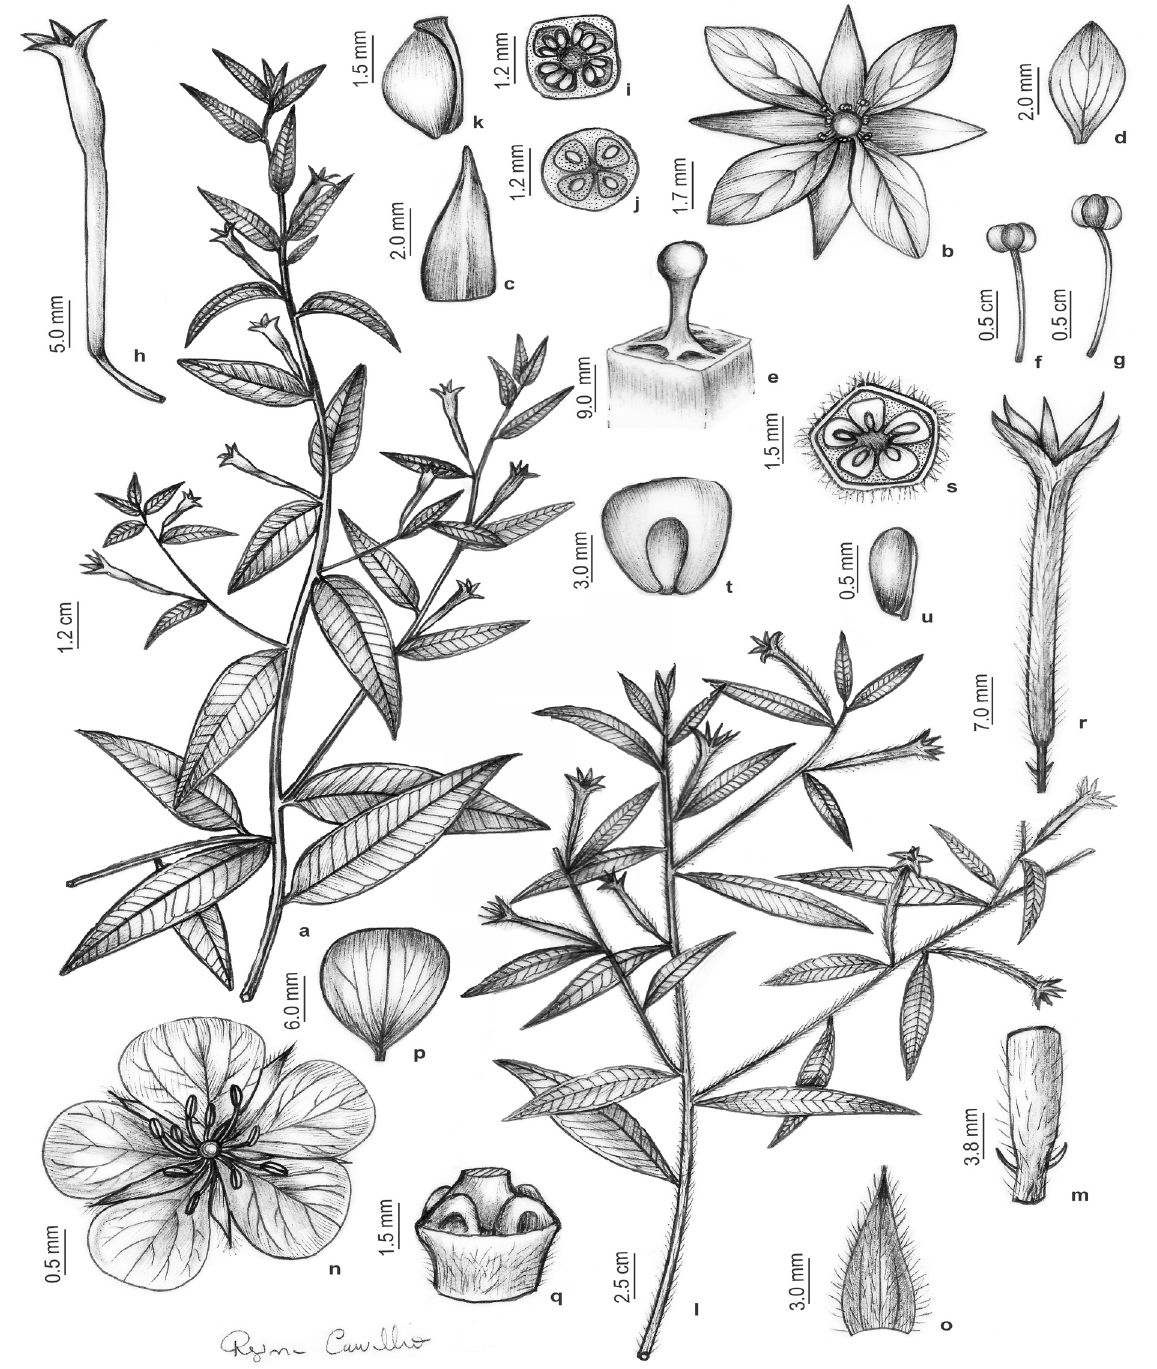
Fig. 6. a – k . Ludwigia hyssopifolia (G.Don) Exell, A.M. Rocha 16 . a . Habit. b . Flower. c . Sepal. d . Petal. e . Plain nectariferous disk. f . Epipetalous stamen. g . Episepalous stamen. h . Fruit. i . Transversal cut of the upper section of the fruit. j . Transversal cut of the lower section of the fruit. k . Seed. – l – u . L. leptocarpa (Nutt.) H.Hara, A.M. Rocha 06 . l . Habit. m . Bracteoles. n . Flower. o . Sepal. p . Petal. q . Convex nectariferous disk. r . Fruit. s . Transversal cut of the fruit. t . Section of the horseshoe-shape endocarp. u . Seed. Illustrations by R.M.A. de